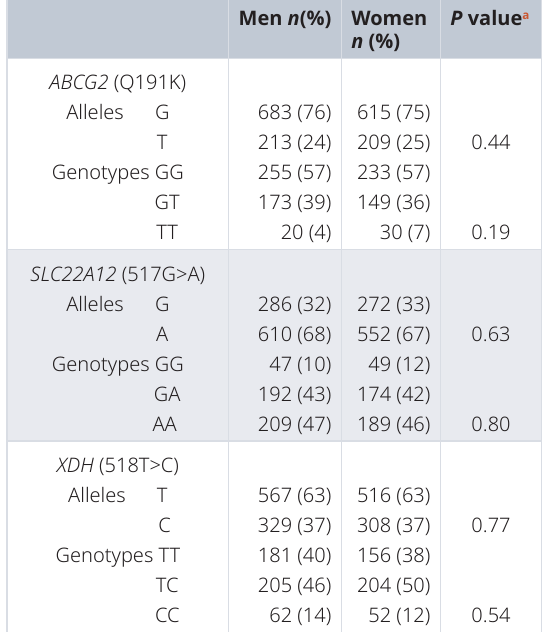
Table 2. Allele and genotype frequencies between male and female